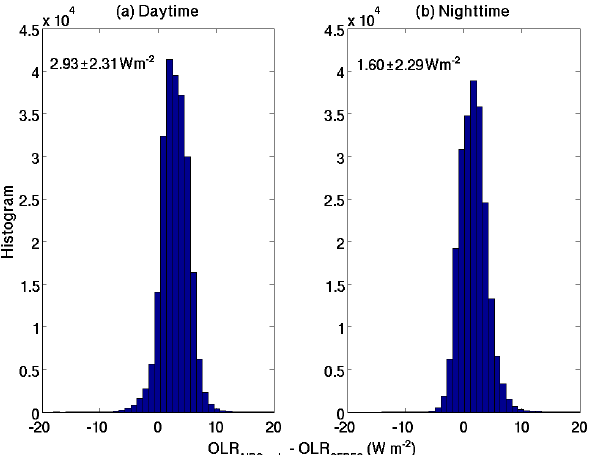
Figure 7. (a) Success rate of the algorithm in distinguishing clear- sky and cloudy-sky footprints as a function of viewing zenith an- gle (VZA). (b) The difference of OLR AIRS-only –OLR CERES as a function of VZA. Ticked vertical lines denote the ± 1 σ (standard